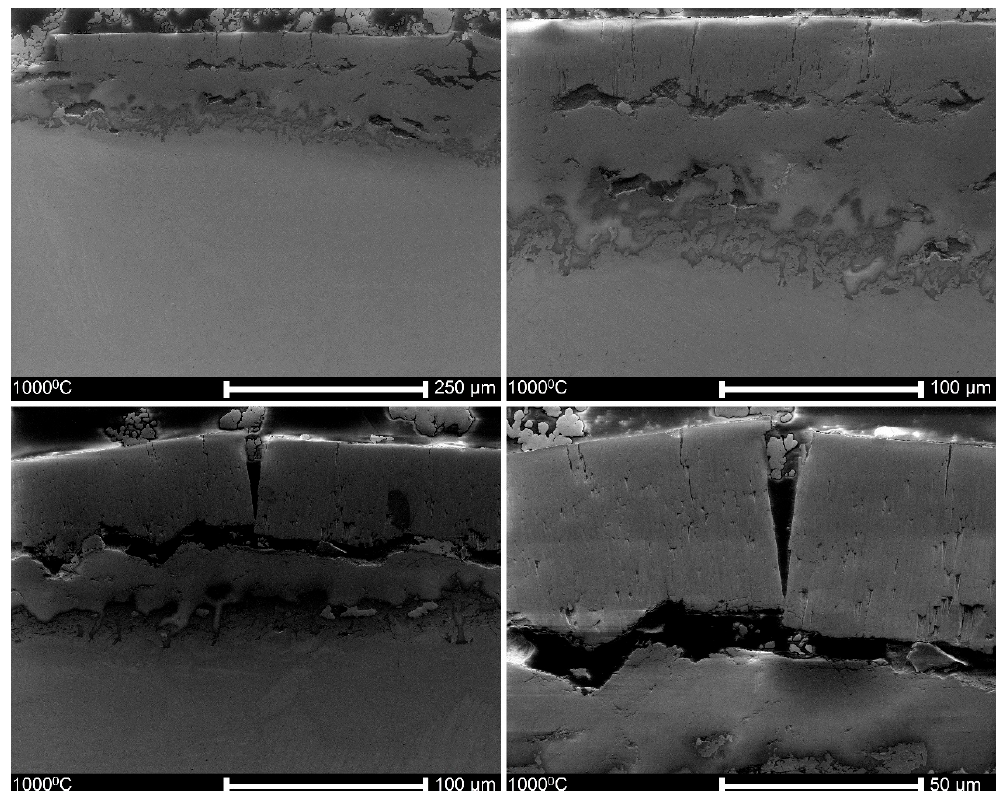
Figure 1. Surface topography of the alloy oxidized at different temperatures.